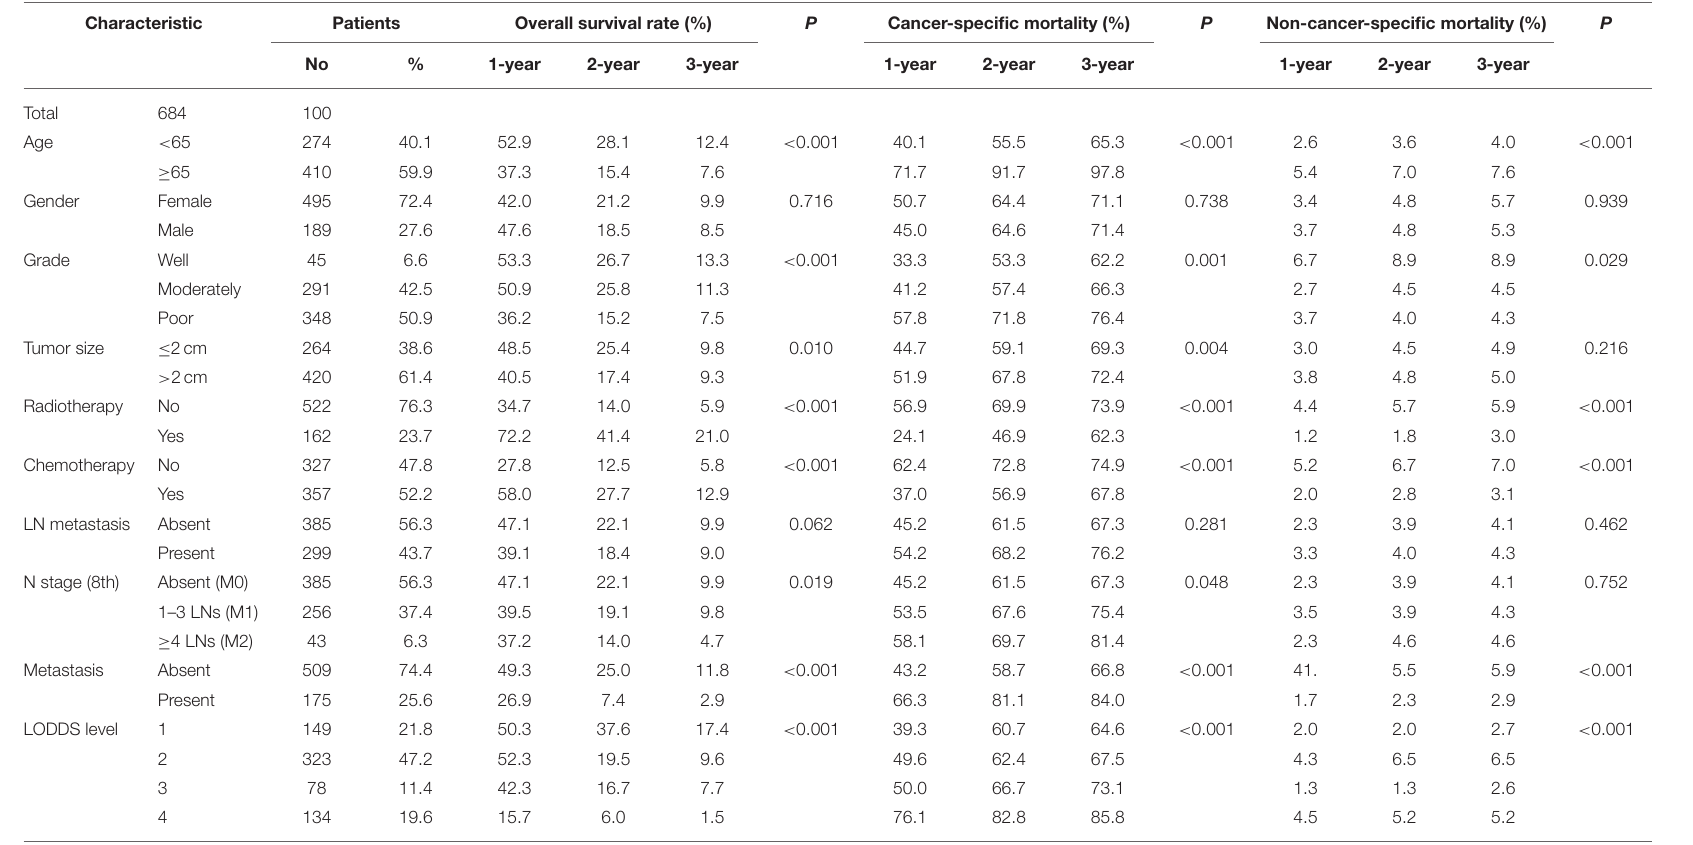
TABLE 1 | Overall survival rates and cumulative incidences of mortality among patients with gallbladder cancer. Characteristic Patients Overall survival rate (%) P Cancer-specific mortality (%) Non-cancer-specific mortality